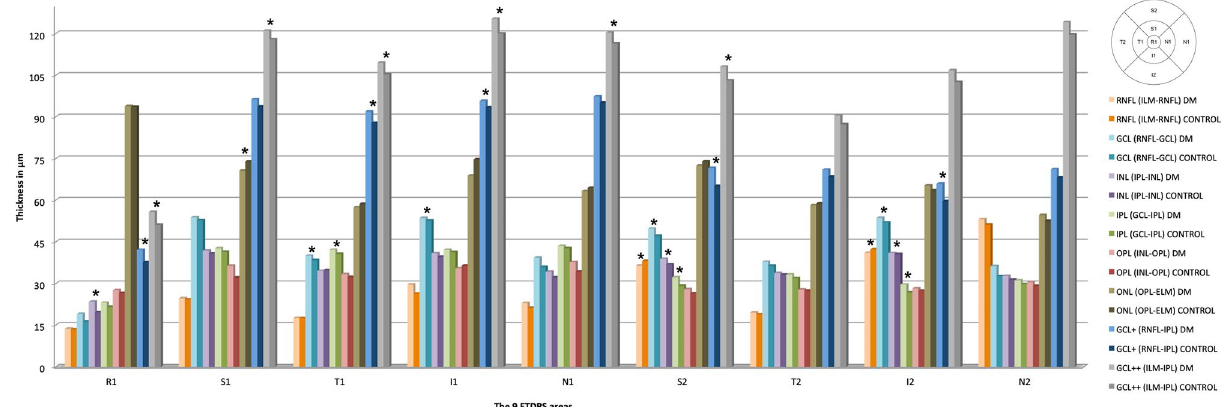
Figure 3. Spectralis SD-OCT mean thickness per ETDRS area is in μm, and statistical significance with p < 0.05 is marked with * of the RNFL (from the ILM to the RNFL), GCL (from the RNFL to the GCL), IPL (from the GCL to the IPL), INL (from the IPL to the INL), OPL (from the INL to the OPL), ONL (from the OPL to the ELM), GCL+ (from the RNFL to the IPL, adding GCL and IPL) and GCL++ (GCC) in the diabetic and control groups. DM Diabetes mellitus, ETDRS Early Treatment of Diabetic Retinopathy Study, RNFL Retinal nerve fiber layer, ILM Inner limiting membrane, GCL Ganglion cell layer, IPL Inner plexiform layer, INL Inner nuclear layer, OPL Outer plexiform layer, ONL Outer nuclear layer, ELM External limiting membrane, R1 Central, S Superior, T Temporal, I Inferior, N Nasal, 1 corresponds to the values of the 3 mm parafoveal inner circle, and 2 corresponds to the values of the 6 mm peripheral outer circle.